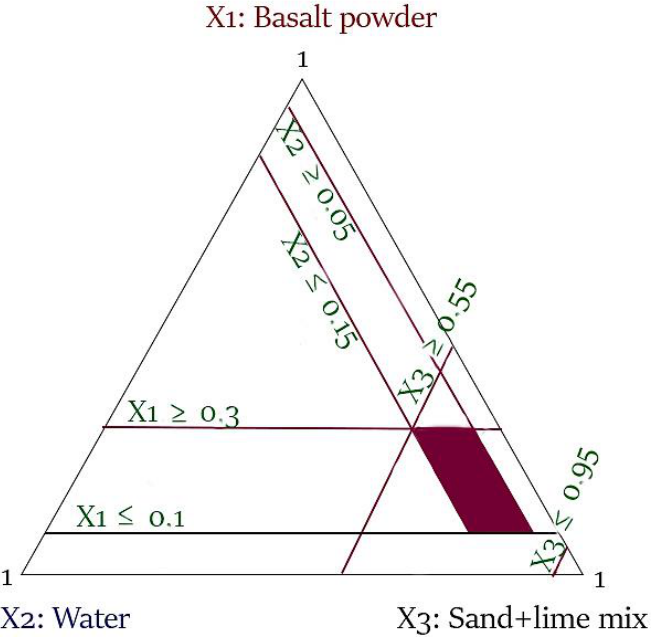
Figure 2. Model of a mixture experiment design with constraints for three independent variables.